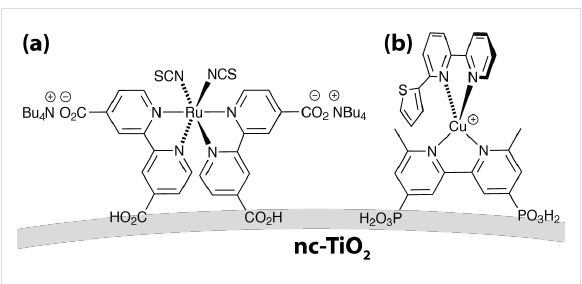
Figure 3: Schematic structures of (a) the standard dye N719 and (b) a copper(I)-based dye, assembled in situ (see text).